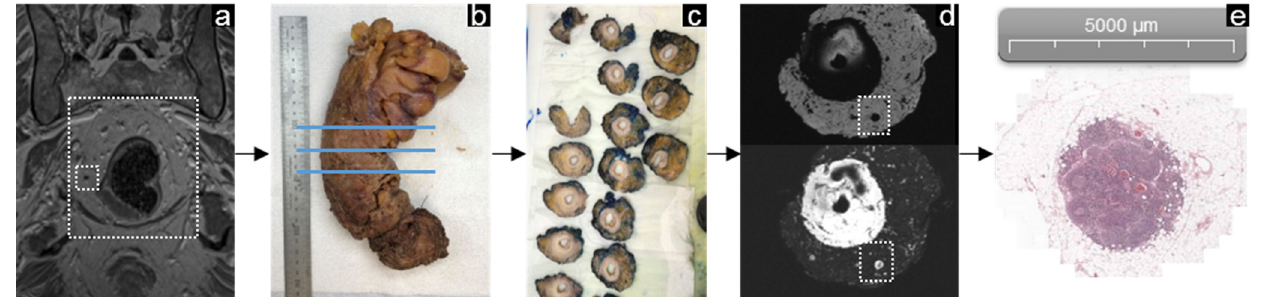
Figure 4. Example of the workflow in rectal cancer. A coronal view of the in vivo MRI showing the rectum within the white dashed lined box with a non-suspicious lymph node located right pararectally close to the rectal wall ( a ). After TME surgery, the specimen was fixated in formalin ( b ), of which an ex vivo MRI scan was performed. After the ex vivo scan, the specimen was sliced in 5 mm thick lamina slices ( c ), which can be compared to the transverse images of the ex vivo MRI ( d ). The lymph node was detected on ex vivo MRI as well as on pathology. Since the USPIO surgery interval was 9 days, and USPIO was no longer present in the resection specimen, and there were no changes in signal intensity. For this reason, the lymph node maintained a signal on the water-selective ex vivo MR image ( d ). Histopathological assessment with hematoxylin and eosin staining revealed a non-metastatic lymph node ( e ).